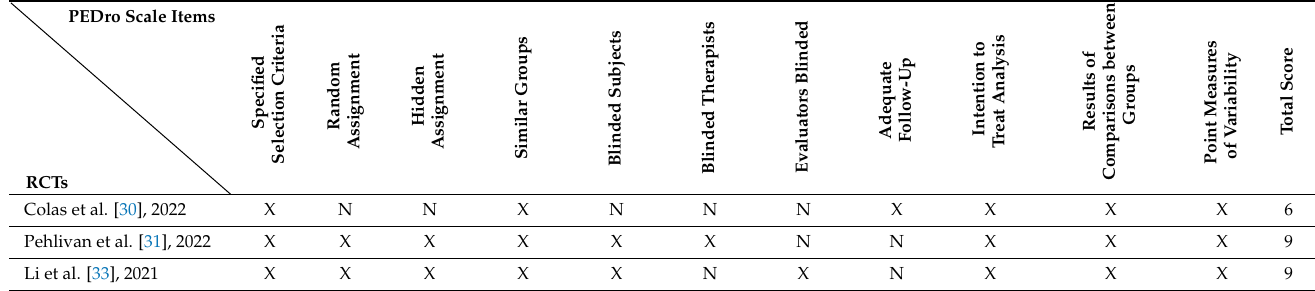
Table 3. Evaluation of the methodological quality of the articles included with the PEDro Scale